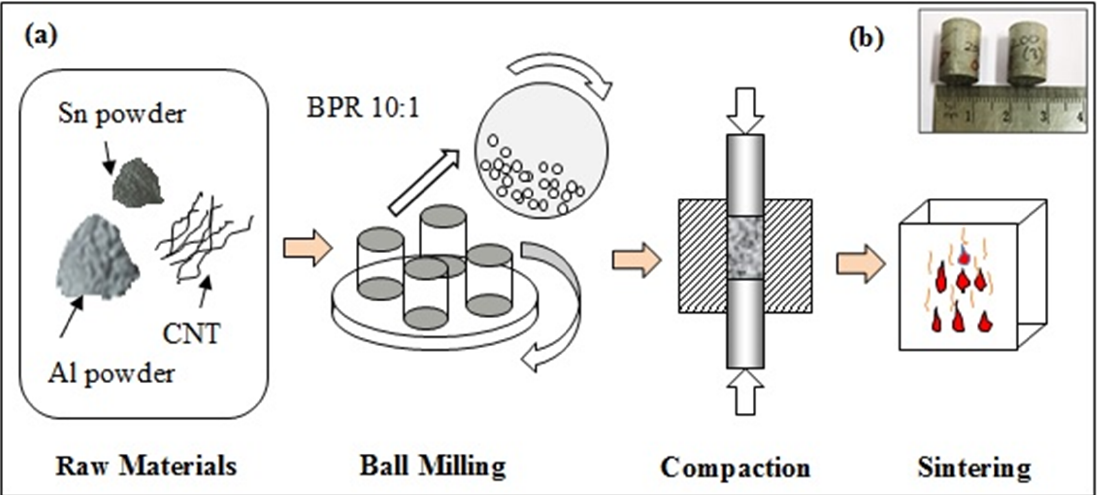
Figure 2. ( a ) A schematic representation of steps in consolidation of composites. ( b ) sintered Al-CNT-Sn Composites.